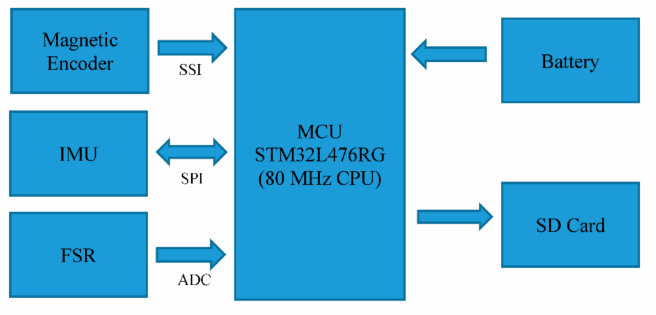
Figure 3. Sensor interfacing and data acquisition